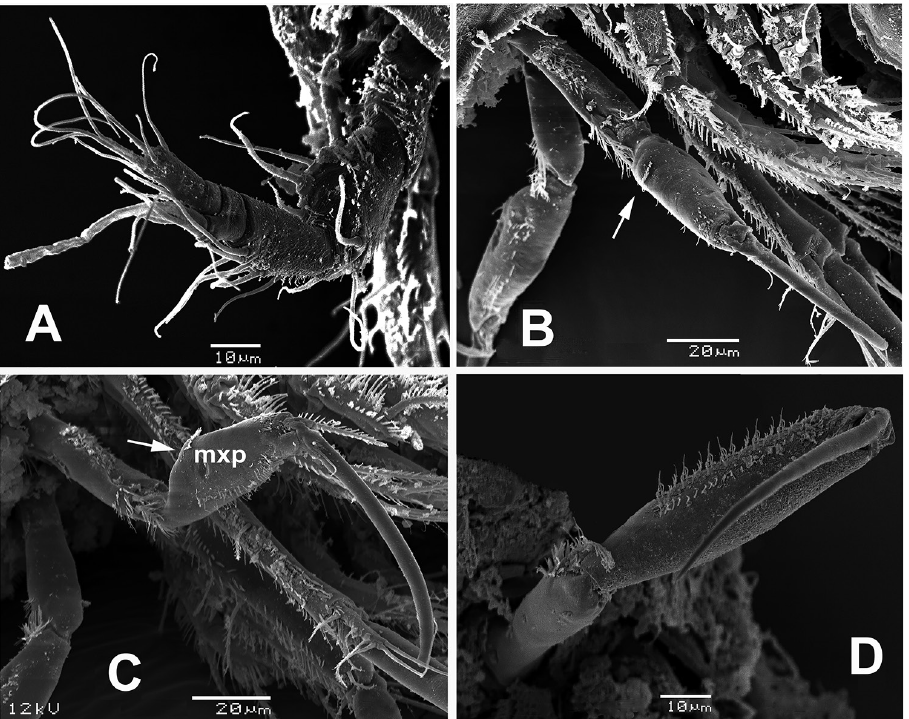
Figure 6. Echinolaophonte villabonae sp. n. , female from Colombia, SEM-prepared specimen. A anten- nule B maxilliped showing proximal position of spinule comb (arrow); E. armiger female from Colombia C maxilliped showing medial position of spinule comb D male